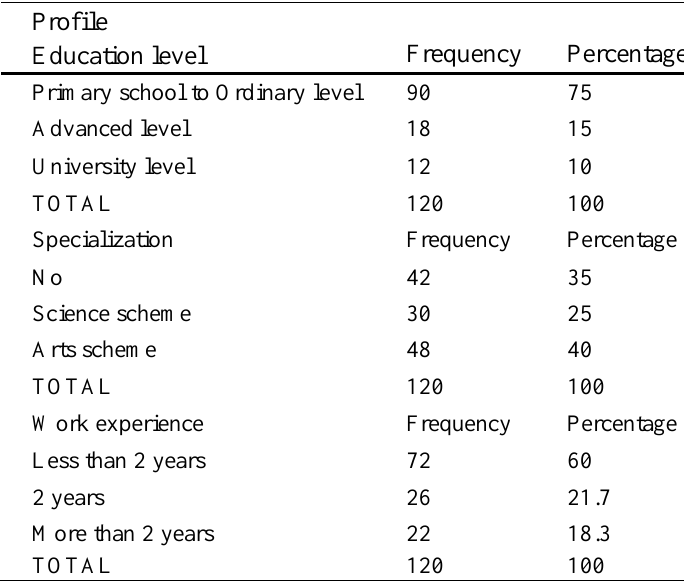
Table 1. Demographic profile of the